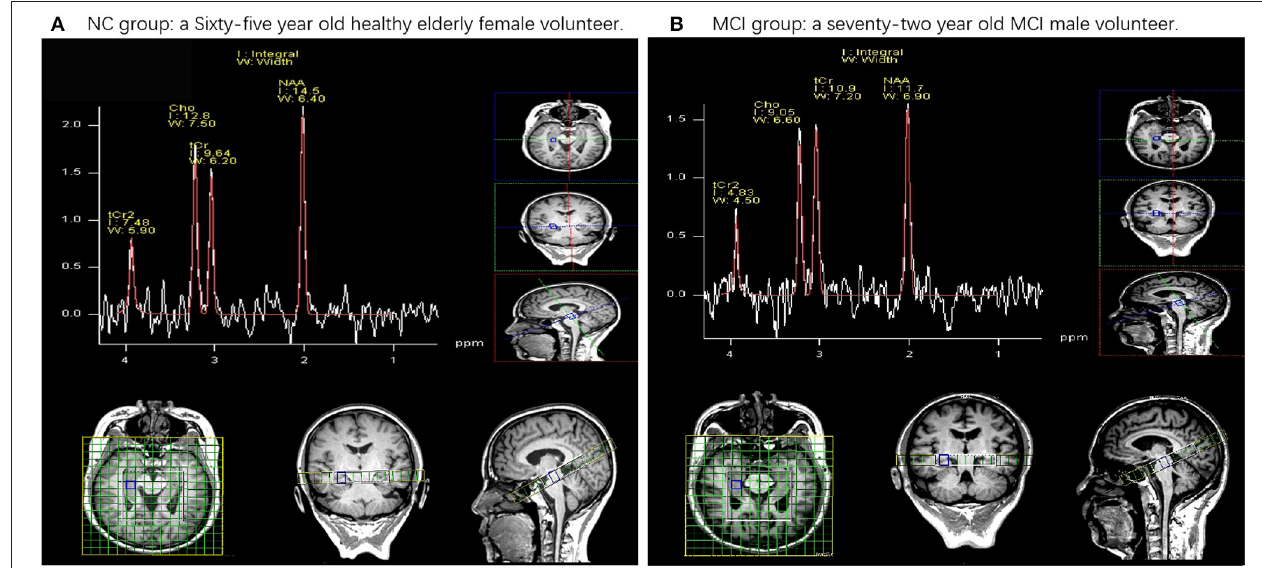
FIGURE 2 | Examples of the data of 1H magnetic resonance spectroscopy (MRS) obtained in healthy elderly female volunteers and mild cognitive impairment (MCI) male volunteers. NAA, N -acetyl aspartate; tCr, total creatinine; Cho, choline. (A) Demonstrates a 65-year-old healthy elderly female volunteer. These ratios are (NAA/tCr = 1.50, Cho/Cr = 1.33) in the right hip. (B) Demonstrates a 72-year-old MCI male volunteer. These ratios are (NAA/tCr = 1.07, Cho/tCr = 0.83) in the right hip. A prospective study found that the ratio of NAA/Cr in the tests for analysis, where the accuracy was higher. Because of PCG and the left occipital lobe showed high sensitivity and the different choices, such as brain function area and race, the specificity for predicting the progression of AD in MCI, with cutoff point of NAA/Cr may be different. In this study for the the values of sensitivity being 0.82 and 0.72, respectively, and the elderly in China, we found that the sensitivity of NAA/tCr to values of specificity being 0.78 and 0.69, respectively ( Fayed et al., cognitive impairment was higher than that of Cho/tCr. The cutoff 2008). Similarly, Modrego et al. (2011) reported that, when the point of the ratio of NAA/tCr in the left HIP to distinguish a ratio of NAA/Cr in the middle and the rear of bilateral parietal normal cognitive impairment from MCI was 1.195. Sensitivity, lobes was ≤ 1.43, the accuracy and specificity of predicting specificity, and the YDI were 0.725, 0.803, and 0.528, respectively. the conversion of MCI to possible AD were 0.741 and 0.837, In the right HIP, the cutoff point was 1.19. Sensitivity, specificity, respectively, when included in the APOE genotype and memory and the YDI were 0.754, 0.803, and 0.557,